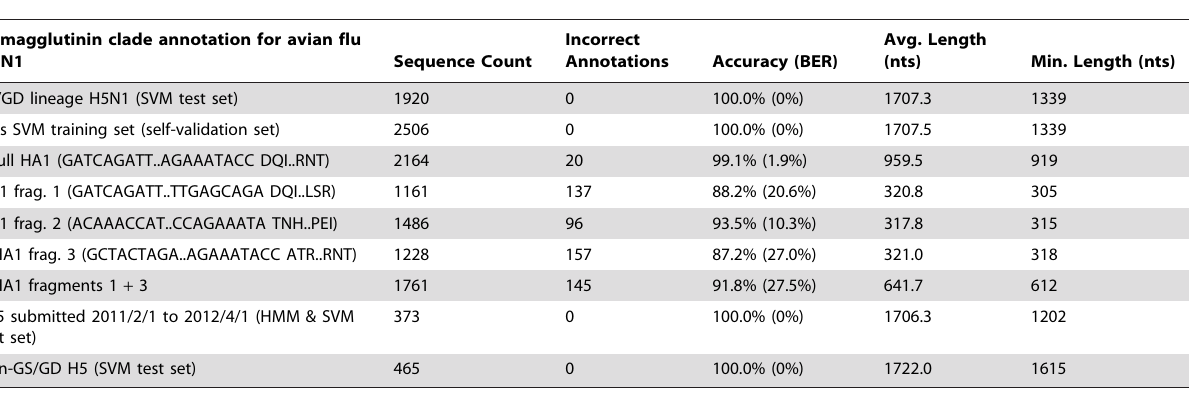
Table 1. Hemagglutinin clade annotation for avian influenza subtype A(H5N1) by LABEL.